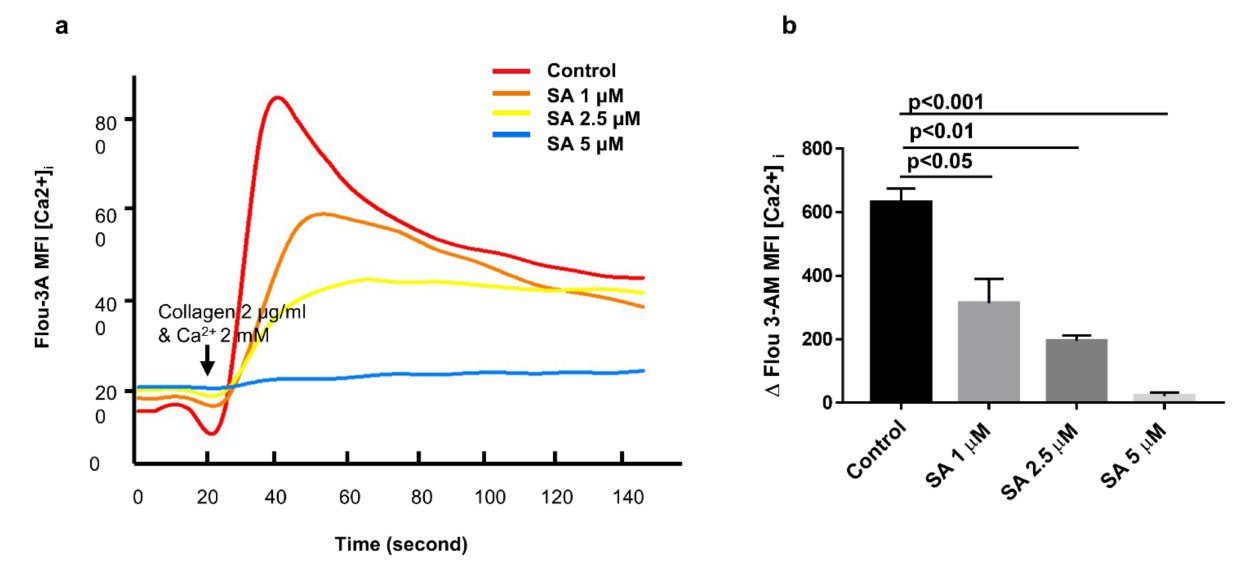
Figure 6. Sanguinarine dose-dependently attenuates intracellular Ca 2+ concentration ([Ca 2+ ]i) in human platelets. ( a ) Intracellular Ca 2+ flux was measured by flow cytometry. Washed human platelets (5 × 10 7 /mL) were labeled with 1 µ